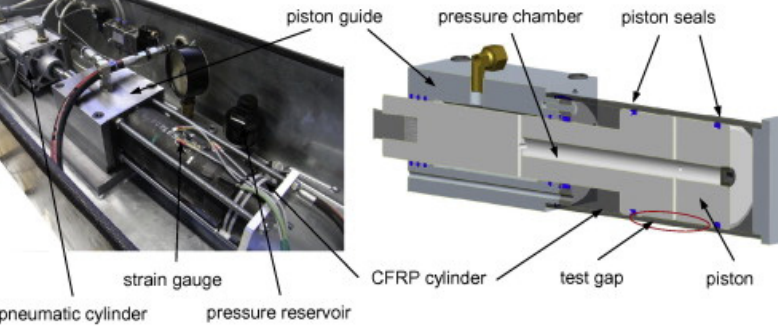
Figure 3. Test configuration (left) and cross-sectional view (right) of the test set-up [20].